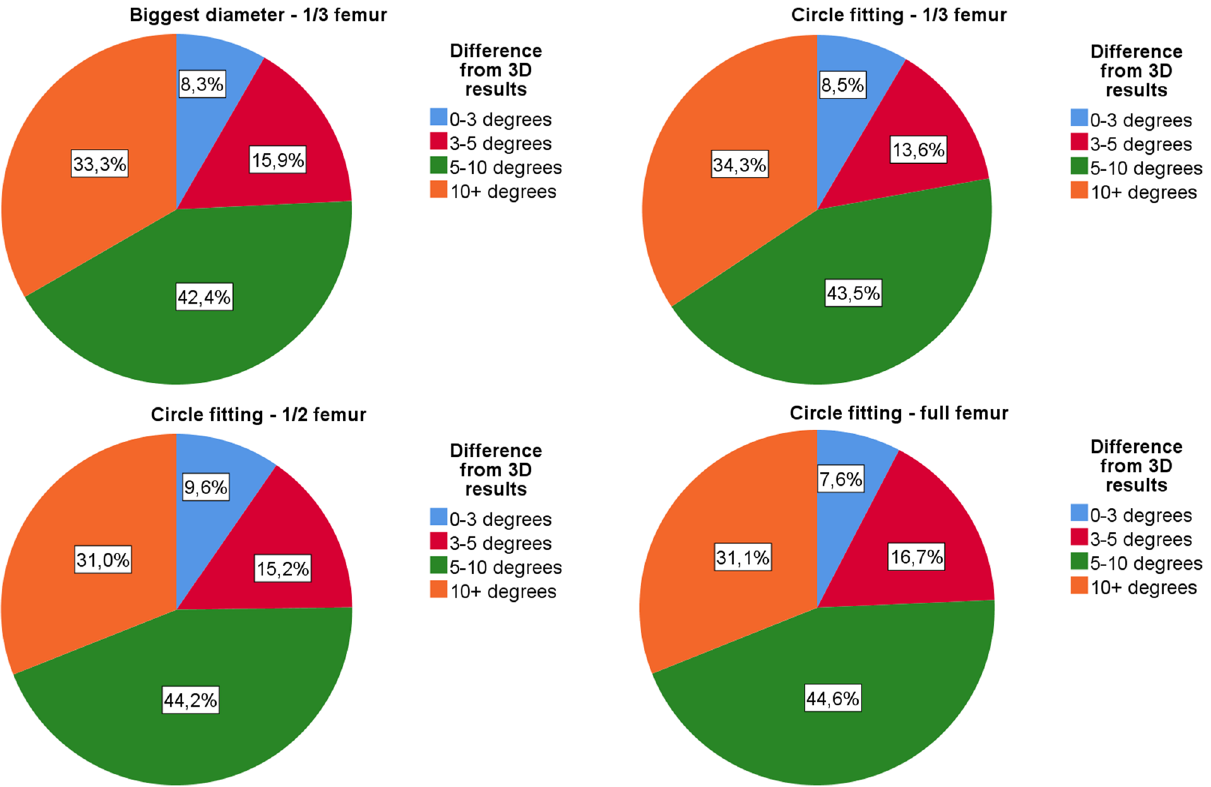
Figure 4. Pile chart of the difference between the 3D reconstructions and each 2D measurement result. Blue— the absolute difference between the 2D and 3D results is less than 3° (7.6–9.6%). Red—the absolute difference between the 2D and 3D results is between 3–5° (13.6–16.7%). Green—the absolute difference between the 2D and 3D results is between 5–10° (42.4–44.6%). Yellow—the absolute difference between the 2D and 3D results is more than 10°